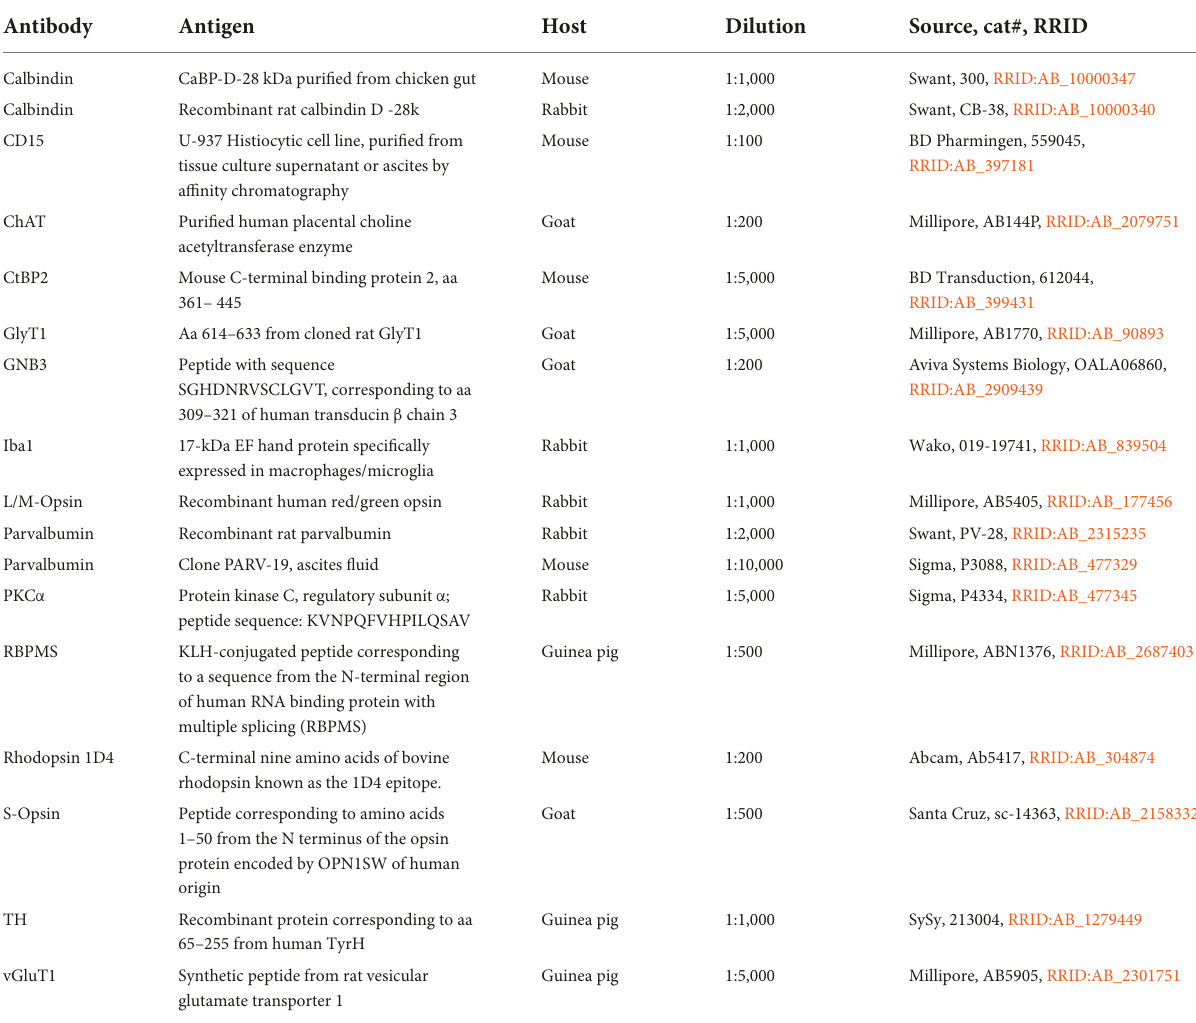
TABLE 1 Primary antibodies used in this